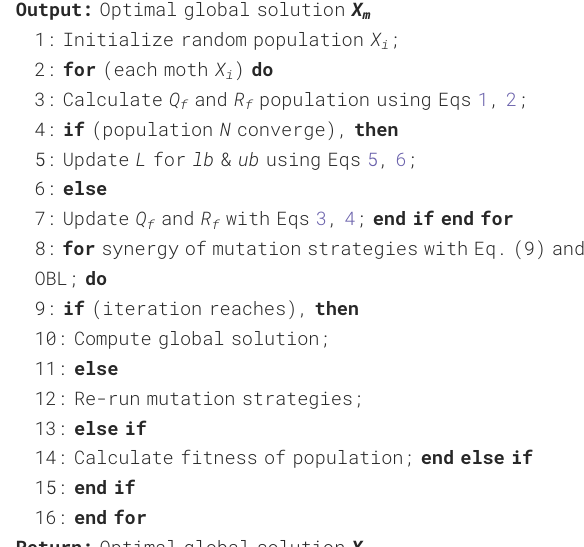
Algorithm 1 Pseudocode of the improved MFOS algorithm.